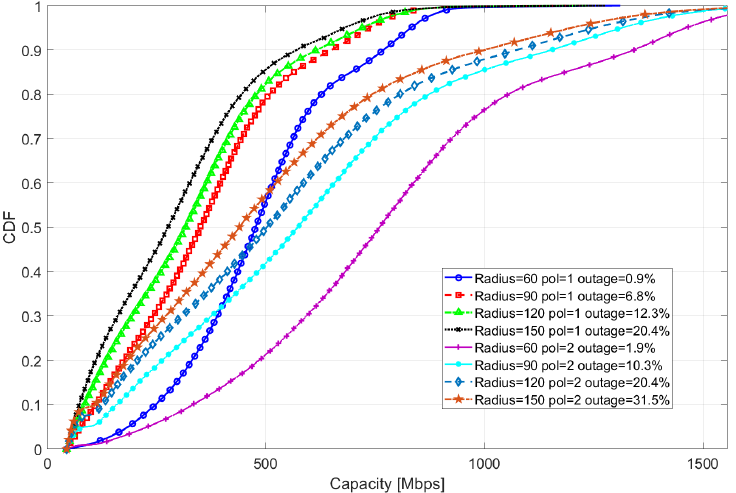
Figure 13. CDF of UT rates for different cell radius lengths, N t = 72 with N ty = 36, N tz = 2, N r = 1,